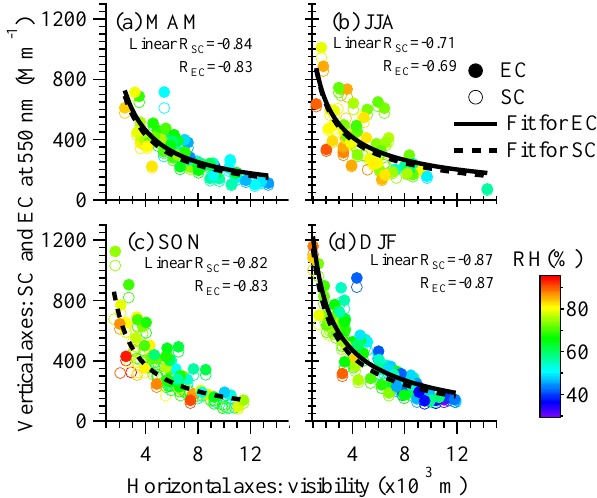
Figure 10. Relationships between SC and visibility (open cycles) and between EC and visibility (solid cycles) in different RH levels in spring (a) , summer (b) , autumn (c) and winter (d) .